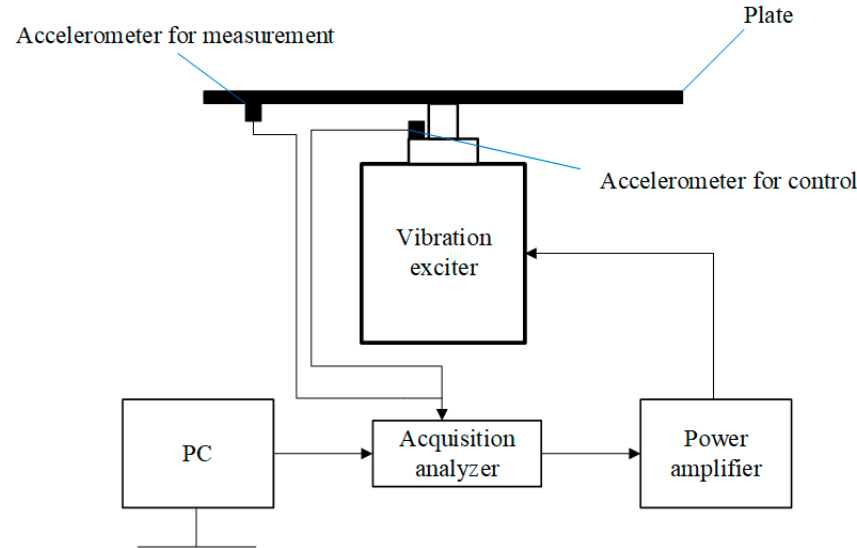
Figure 1. Schematic diagram of the experimental modal-analysis system.